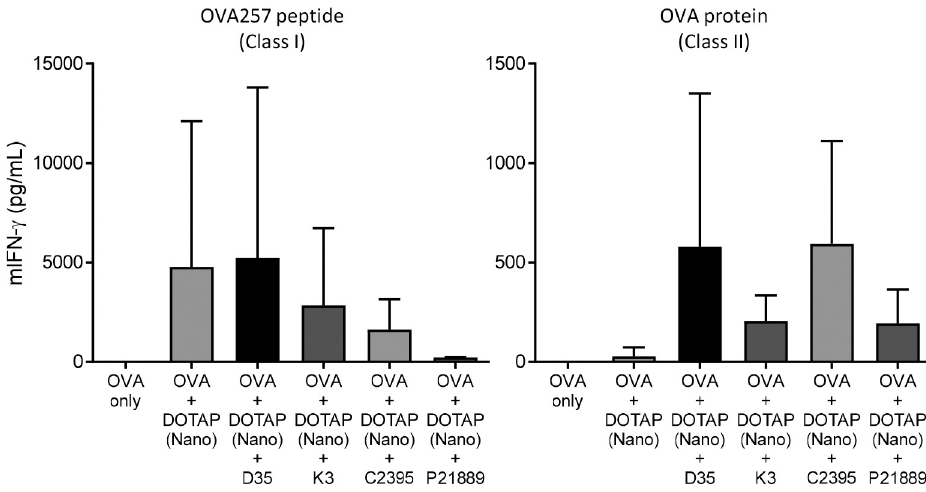
Fig 3. Addition of Type-A CpG further enhanced the adjuvanticity of DOTAP-Nano. C57BL/6J mice were immunized with OVA (10 μ g), OVA plus DOTAP (100 μ g), and OVA/DOTAP plus the indicated CpG adjuvant (10 μ g) at the tail base. After seven days, splenocytes were collected and stimulated with OVA257-264 peptide and OVA protein. Twenty-four hours later, mouse IFN-gamma in the culture supernatant was measured by ELISA. The bar graph indicates the mean ± SD of three mice per